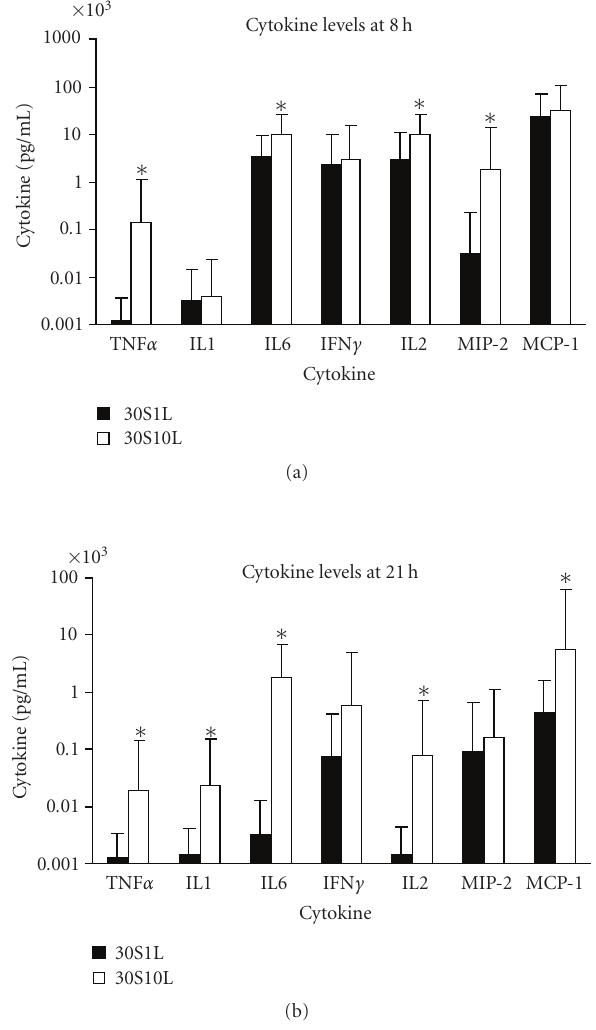
Figure 4: Serum levels of TNF α , IL-1, IL-6, IFN γ , IL-2, MIP-2, and MCP-1 of mice treated with 30 μ g SEB + 1 μ g LPS or 30 μ g SEB + 10 μ g LPS (a) 8 hours after SEB administration (b) 21 hours after SEB administration. Values represent the geometric mean ± SD for each group. The “ ∗ ” indicates P < .05 when comparing the two